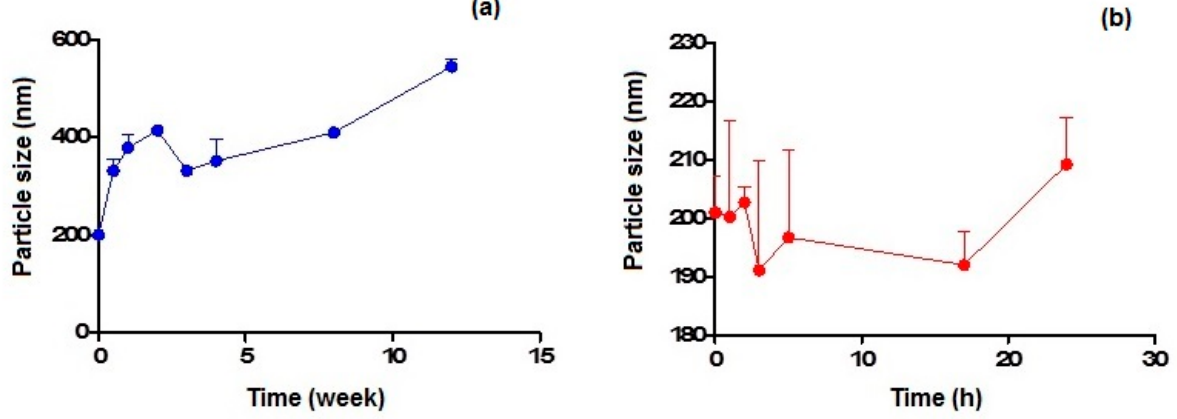
Figure 4. Particle size variation of CIT-SLNs after incubation at: ( a ) 4 °C and ( b ) 37 °C.